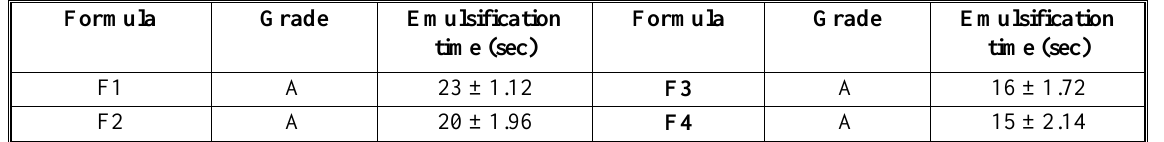
Table 5. Dispersibility and self-micro emulsification time of tacrolimus liquid self-microemulsifying